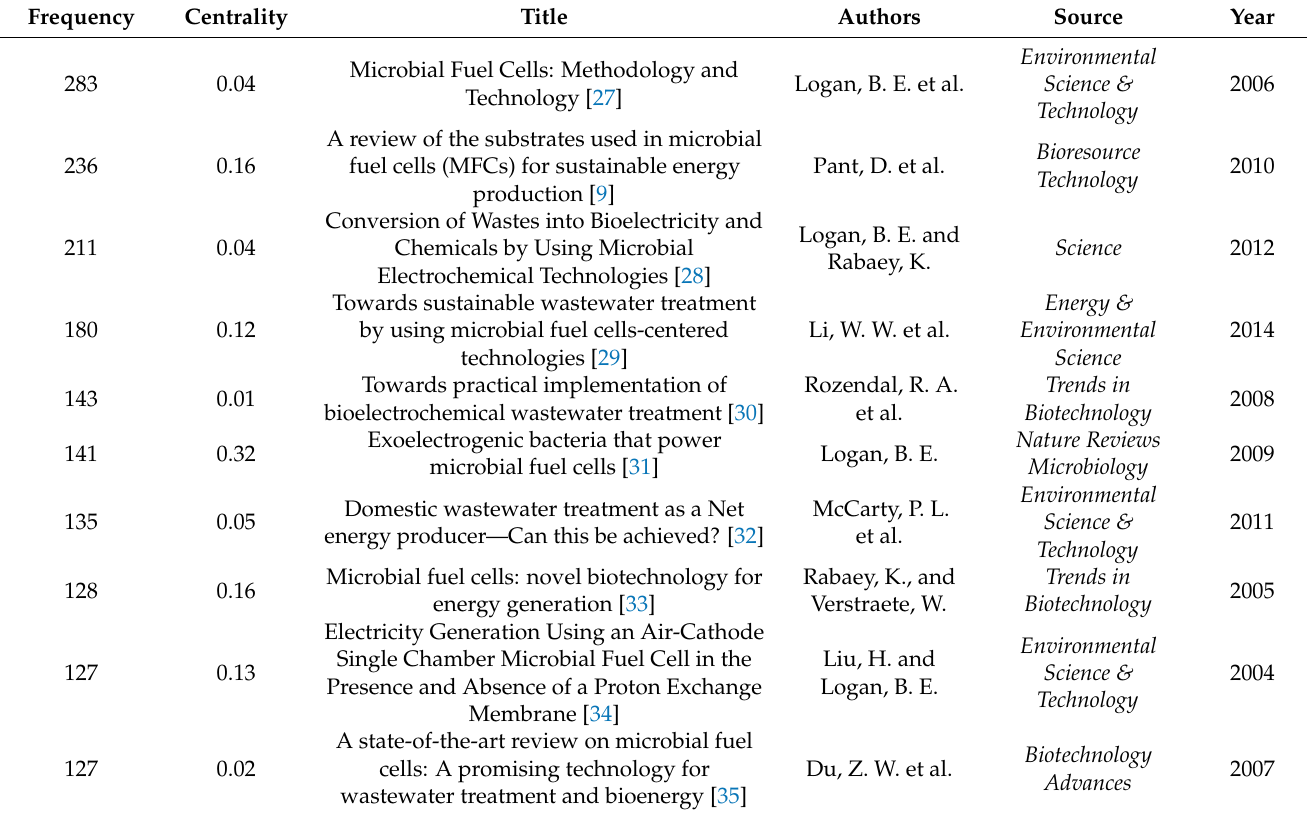
Table 6. The top 10 references on MFCs in wastewater